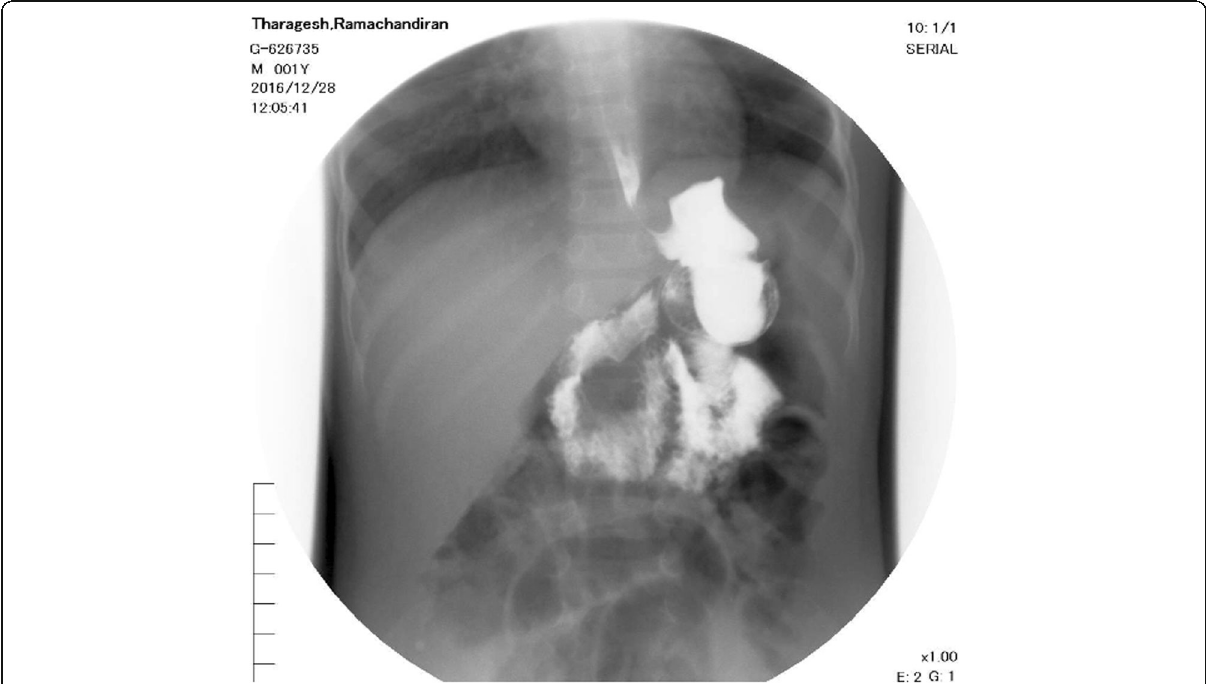
Fig. 4 Post-operative upper GI contrast study at 3 weeks with small capacity